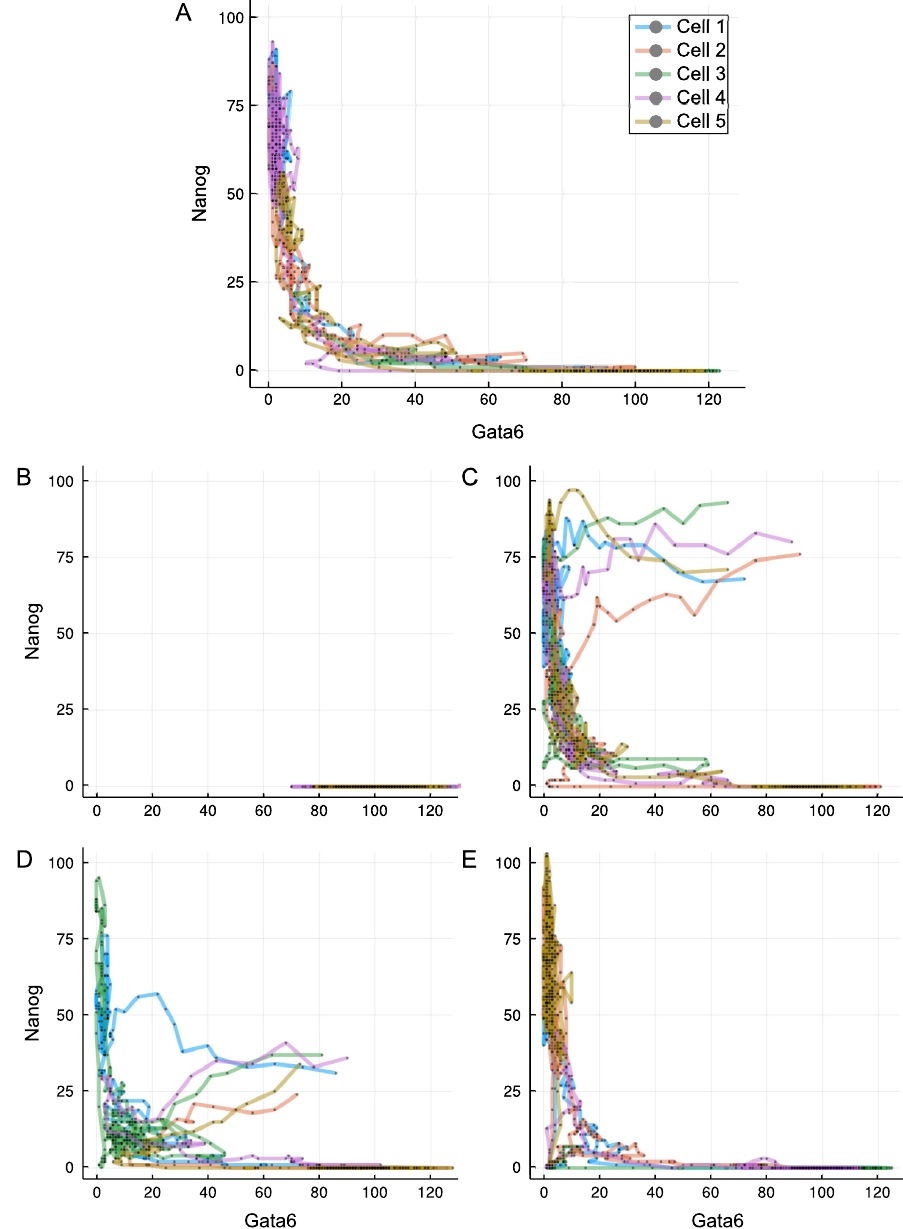
Fig 5. Transition paths during differentiation. (A) Trajectories of five randomly selected stem cells after reduction in LIF concentration ( L = 0), plotted on the Gata6-Nanog phase space. (B) Cells started from the differentiated state and put into L = 200. (C-D) Cells started from the unexplored region of high Gata6 and high Nanog (C) or low Nanog (D) levels for L = 0. (E) Trajectories started from the transition state under L = 50. Different line colours denote different cells, as indicated in the